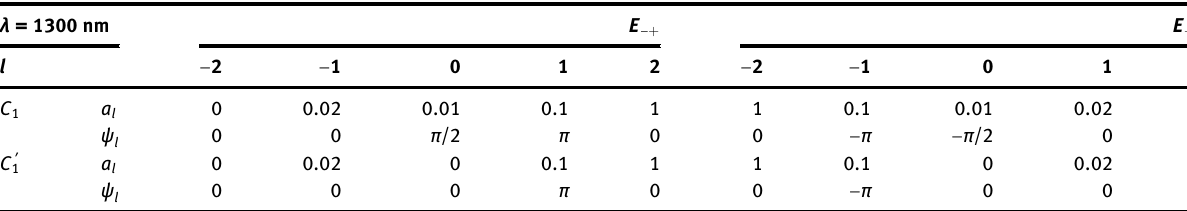
Table  : Table of l th order expansion coef fi cient for λ (cid:2)  nm. λ =  nm